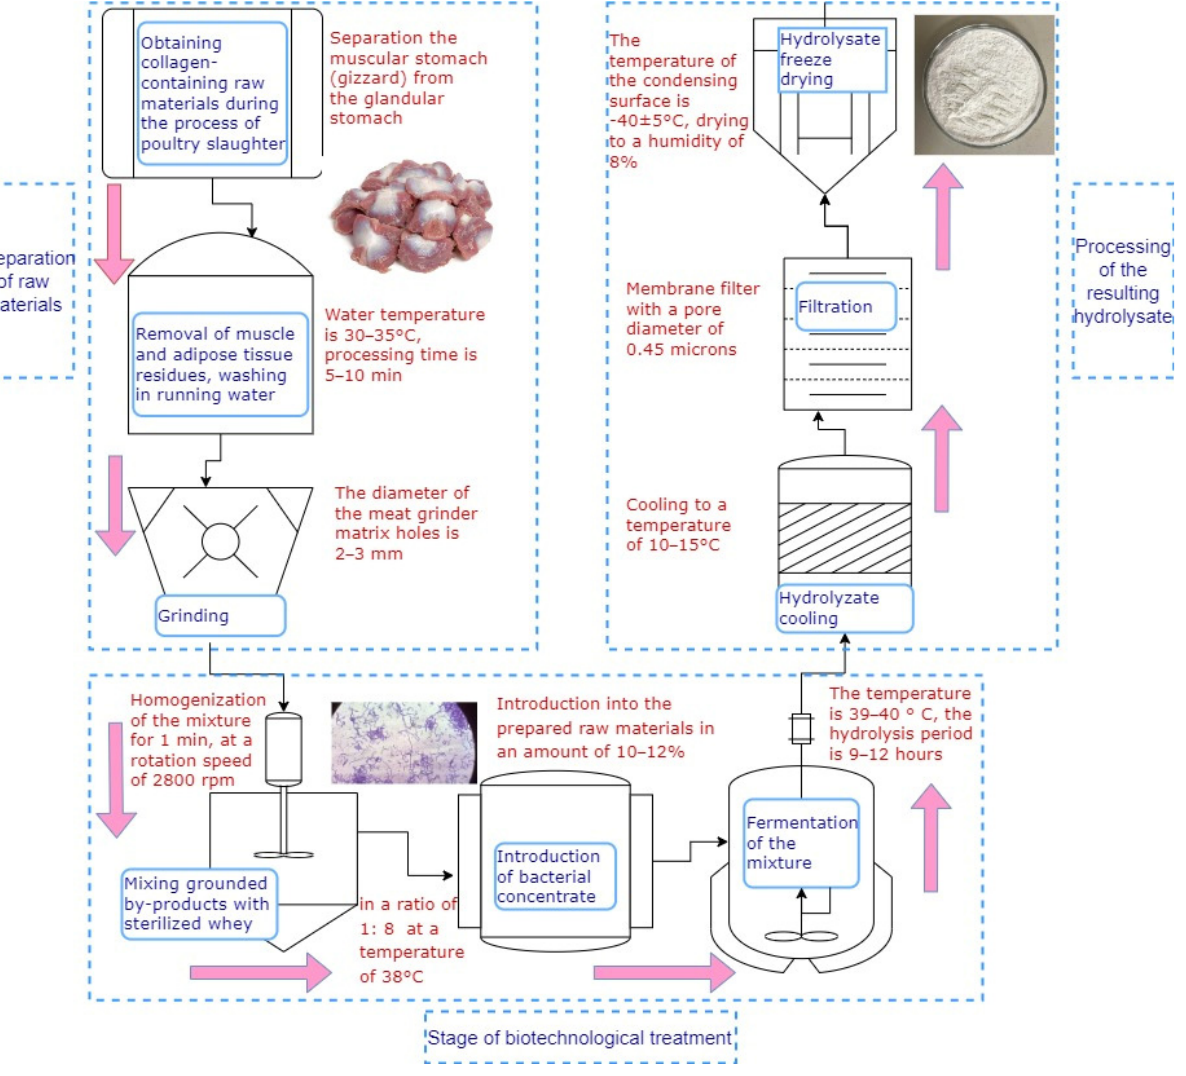
Figure 1. Process flow diagram for obtaining protein hydrolysate from the broiler chicken gizzards.